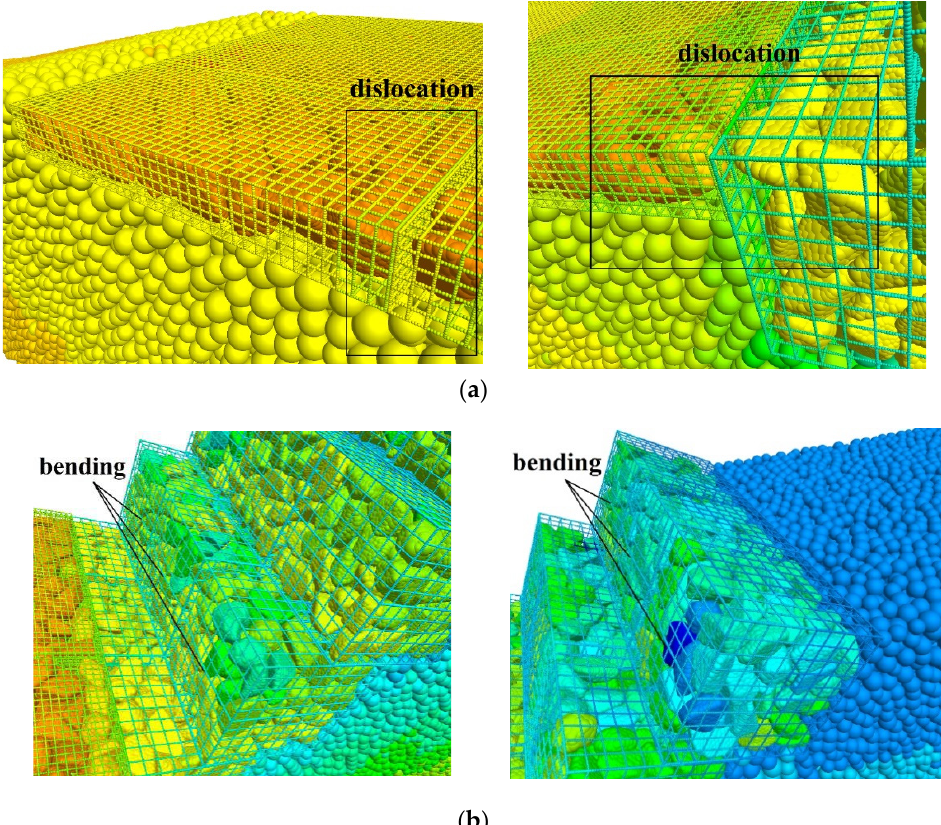
Figure 23. Failure of the gabion slope. ( a ) Dislocation; ( b ) Bending.